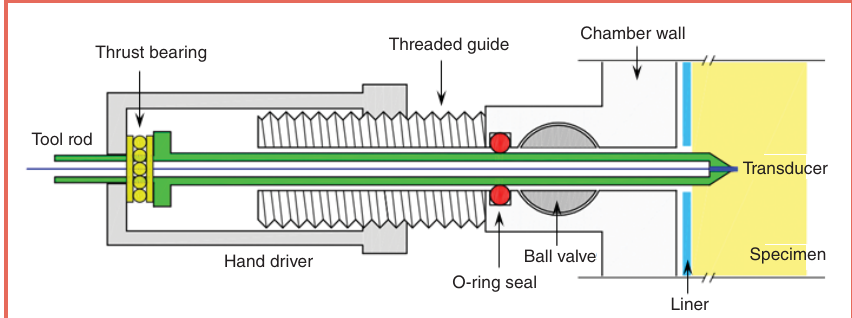
Figure 3. Tool Position. The displacement of sensors, subsampling tools, and drills are controlled under pressure using a screw-based positioning system where the driver advances along the threaded guide while pushing the tool rod (shown in green). Transducers at the tip of the rod are wired through the central hole in the tool rod.